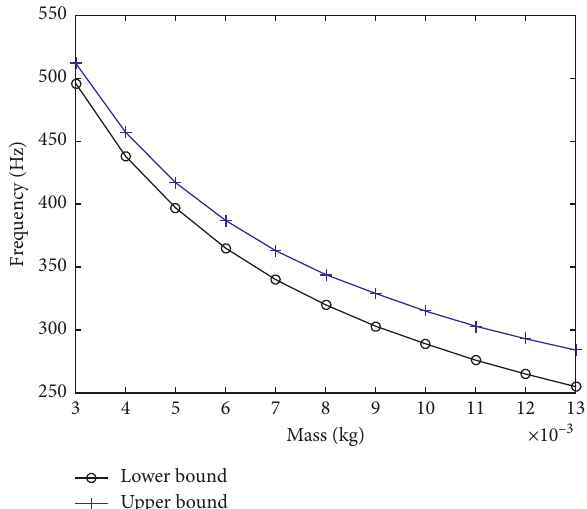
Figure 15: Lower and upper bounds vs. square mass.